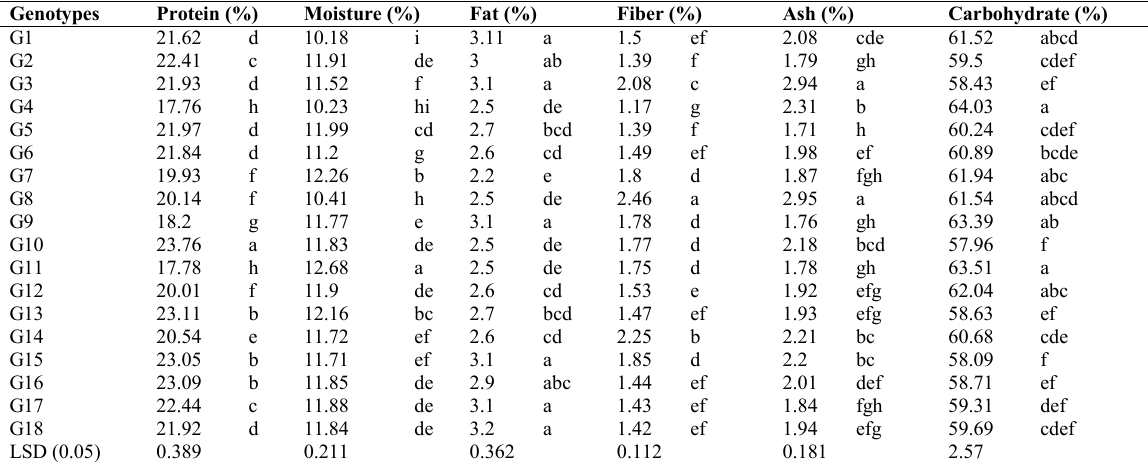
Table 7. Analysis of nutrient components content in kidney bean genotypes.